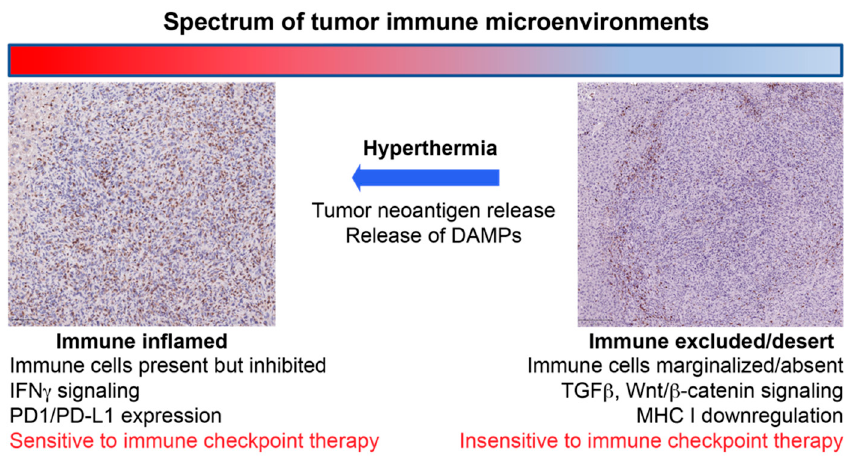
Figure 1. Schematic illustrating the concept of how hyperthermia can convert immunosuppressive tumor immune microenvironments to “inflamed” microenvironments that are sensitive to an immune checkpoint inhibitor therapy.